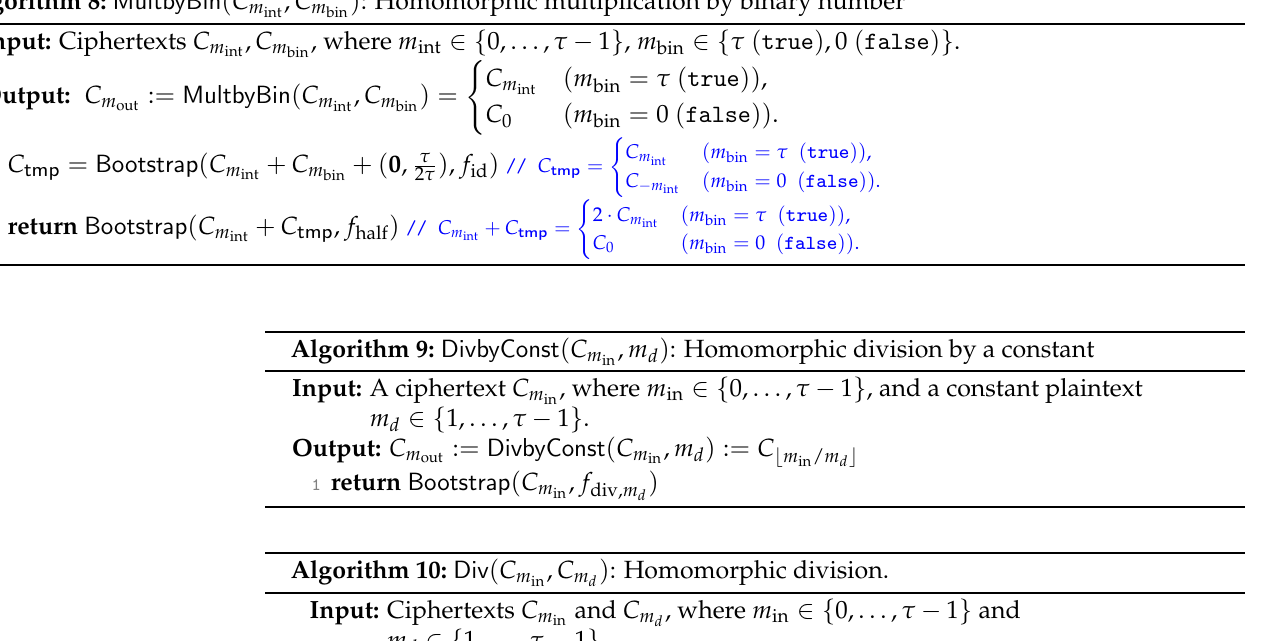
) : Homomorphic multiplication by binary number , C m int bin